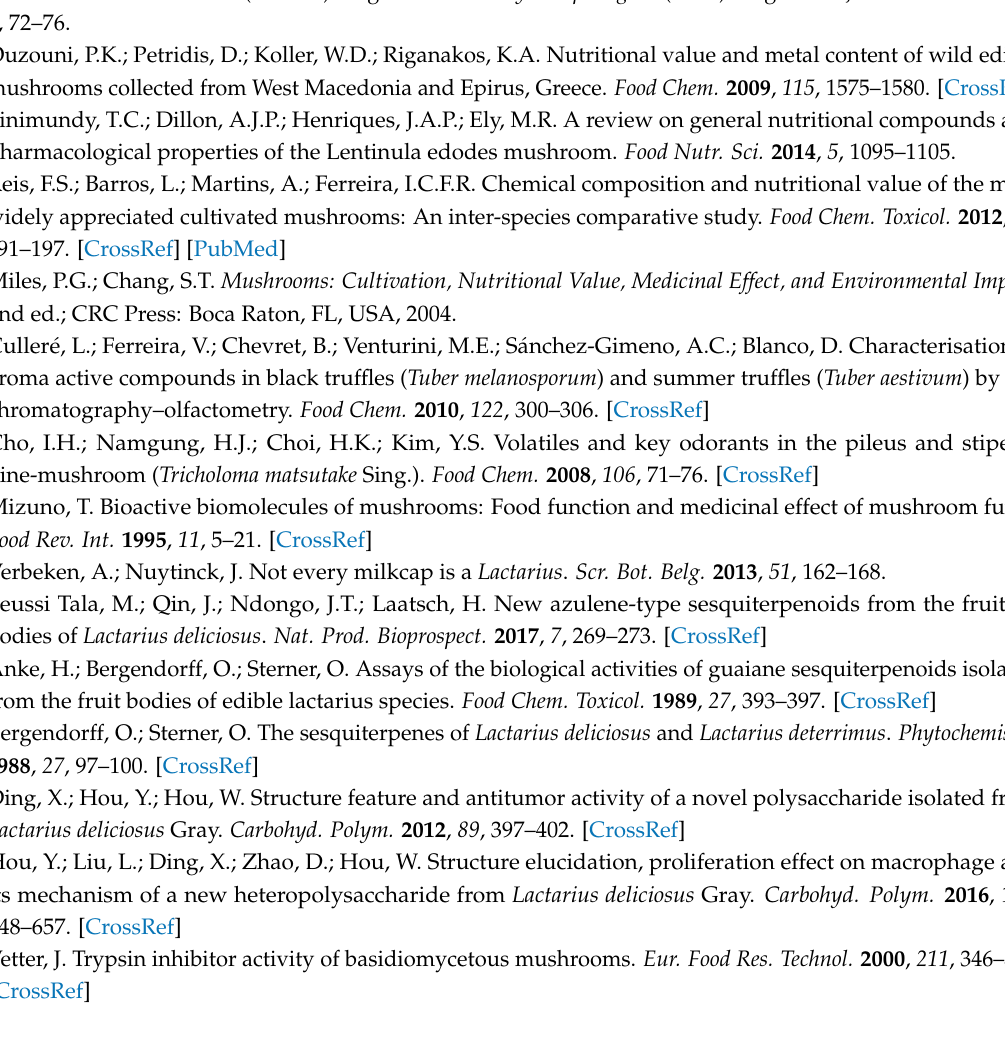
Supplementary Materials: The following are available online, Figure S1: Gas chromatography mass spectrum of fatty acids of L. deliciosus fat; Figure S2: High performance liquid chromatography of amino acids analyzed by online OPA-FMOC derivation; Figure S3: High performance liquid chromatography of flavor 5’-nucleotides; Figure S4: High performance liquid chromatography of organic acids; Figure S5: High performance liquid chromatography of free sugars; and Figure S6: Headspace solid phase micro-extraction gas chromatography mass spectrum of aroma volatile compounds from L. deliciosus